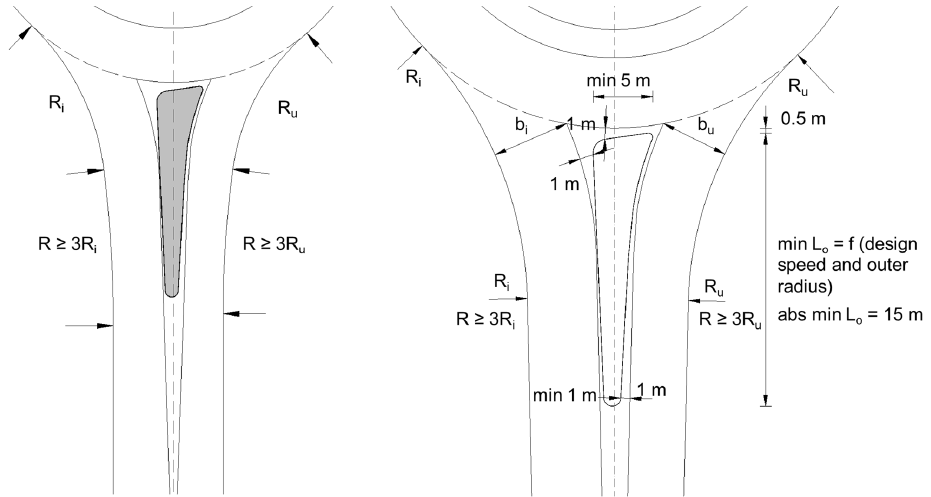
Encyclopedia 2021 , 1 , FOR PEER REVIEW Figure 15. Splitter islands for a high level of traffic-flow channeling [10]. Figure 15. Splitter islands for a high level of traffic-flow channeling [10].